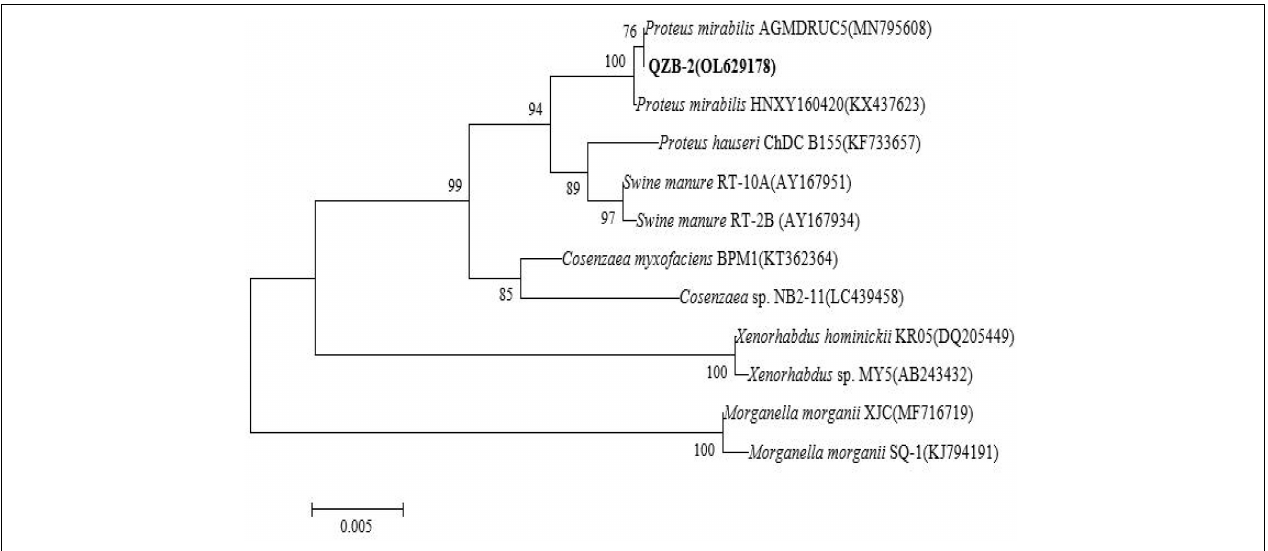
FIGURE 2 | Maximum likelihood tree based on the 16S rRNA gene sequence of isolate QZB-2. The scale bars indicate 0.005 substitutions per site.